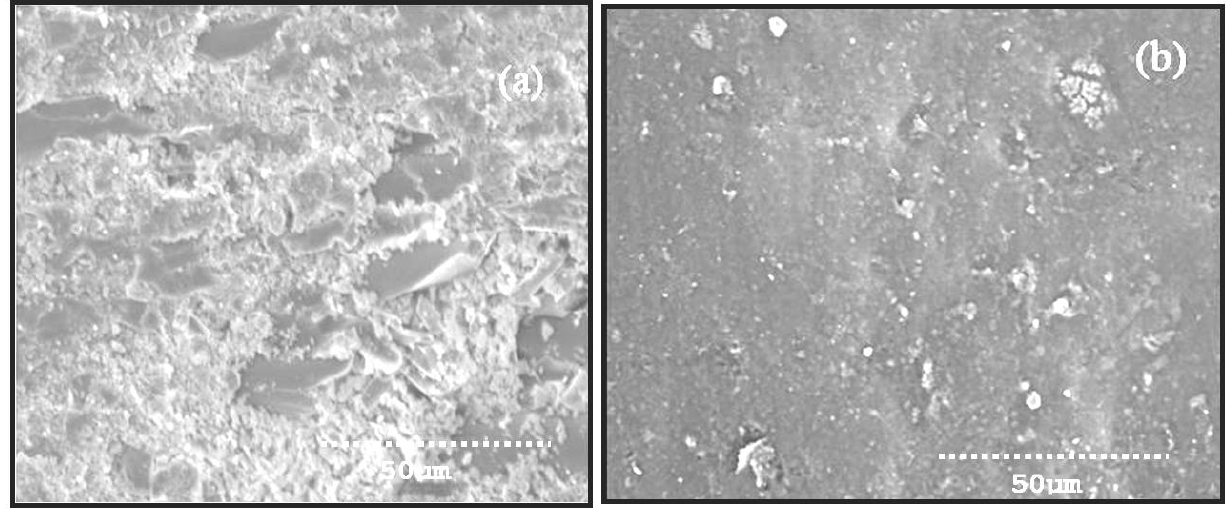
Figure 10. SEM of worn surface of ( a ) GC ( b ) GC 2 composite at 15N load, sliding distance of 75